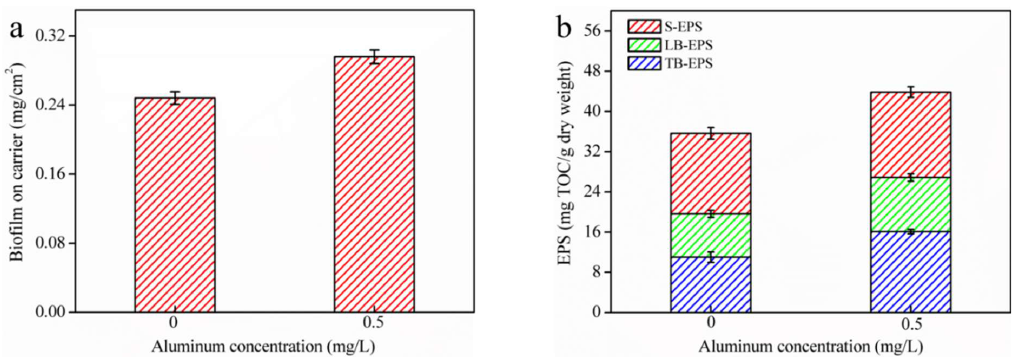
Figure 1. The influence of Aluminum on ( a ) biofilm dry weight and ( b ) extracellular polymeric substances (EPS) fraction content.